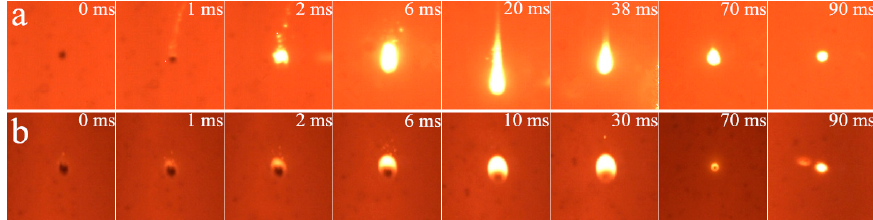
Figure 3. Typical flame images of bituminous coal (BC) and pine sawdust (PS) in 21%O 2 /79%N 2 . ( a ) Bituminous coal (BC); and ( b ) pine sawdust (PS).